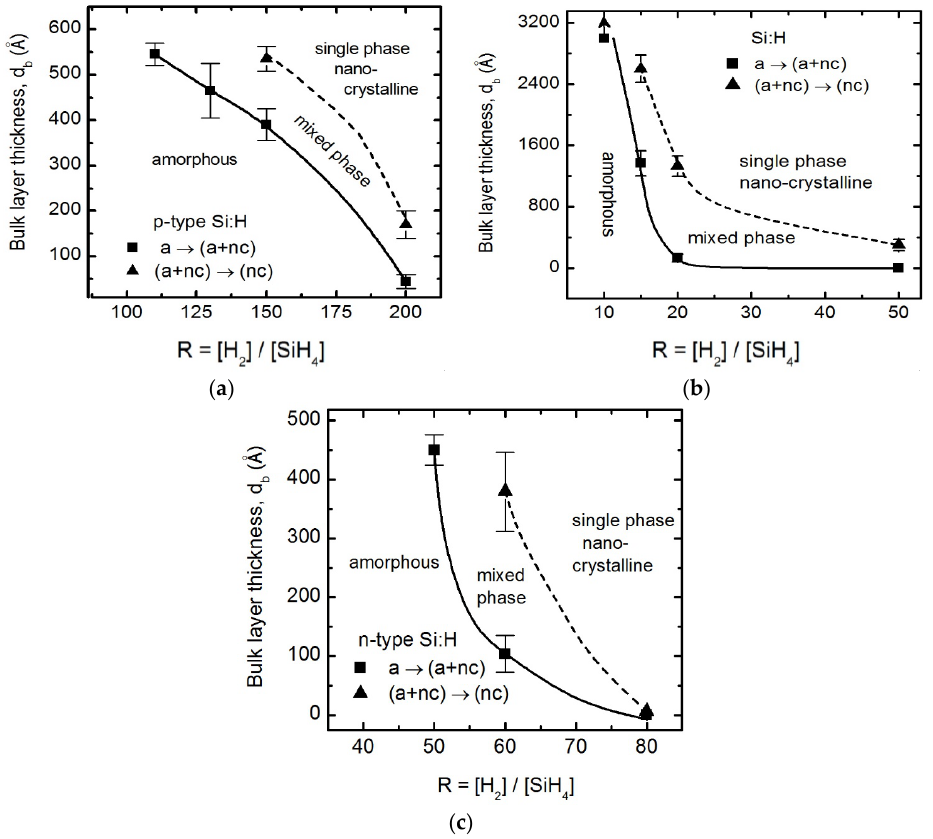
Figure 6. Growth evolution diagrams obtained from analysis of RTSE data for ( a ) p ‐ type; ( b ) intrinsic; and ( c ) n ‐ type Si:H as a function of variable hydrogen dilution R = [H 2 ]/[SiH 4 ] in the n ‐ i ‐ p solar cell device structure. The data values and connecting lines depict the a Ñ (a+nc) and (a+nc) Ñ nc structural transitions of doped and undoped Si:H prepared at conditions described in Table 1. Arrows pointing upward indicate the respective transition occurs beyond the maximum thickness measured.